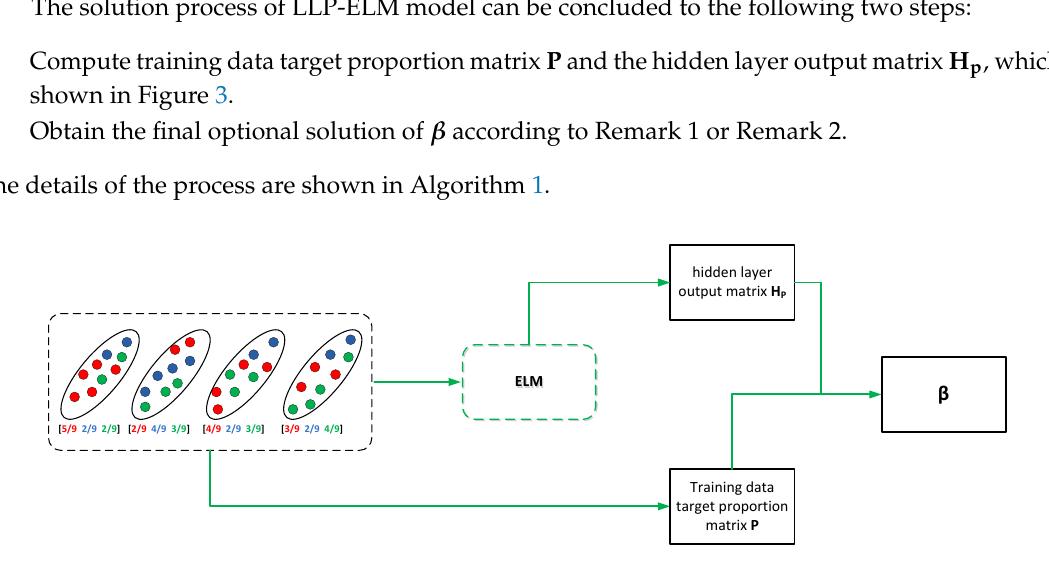
Figure 3. The solution process of learning from label proportions by extreme learning machine